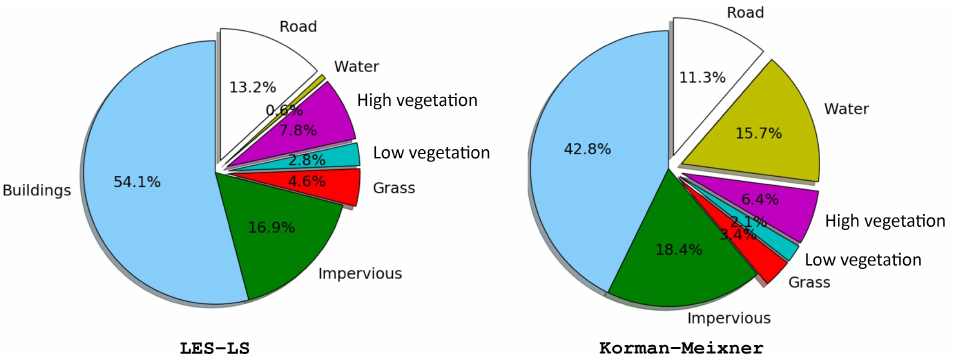
Figure 11. Comparison of source-area fractions a e resulting from applying f LES and f KM to the raster map of land cover types in Fig.